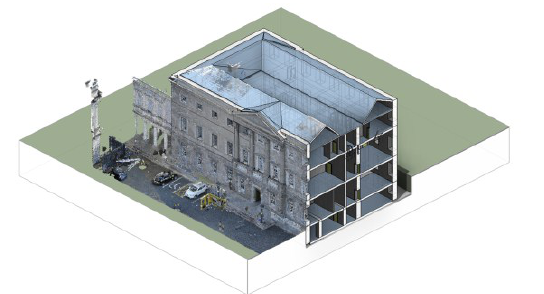
Figure 5: A combination of BIM and Scan for Leinster House